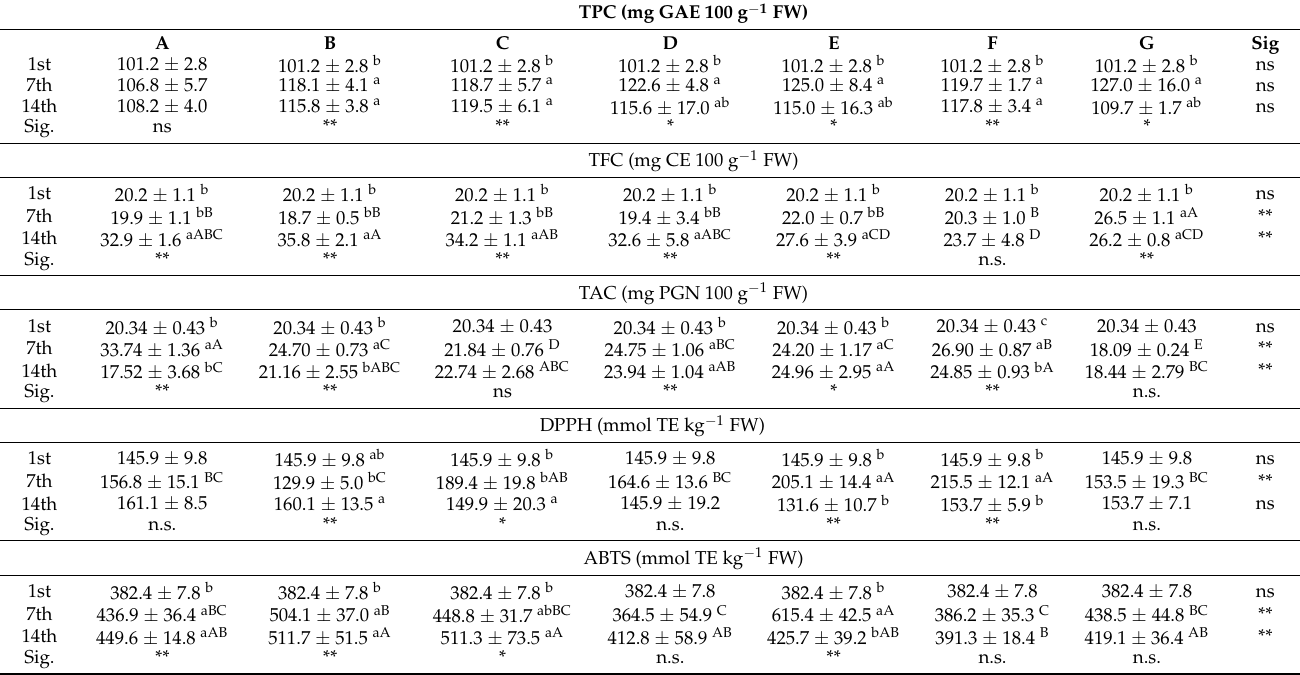
Table 9. Total antioxidant compound levels of minimally treated